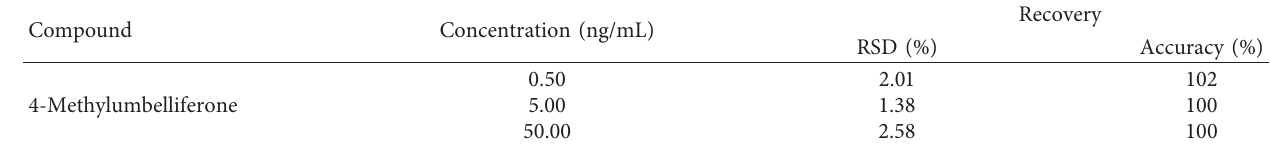
Table 2: The recovery of 4-methylumbelliferone ( n �